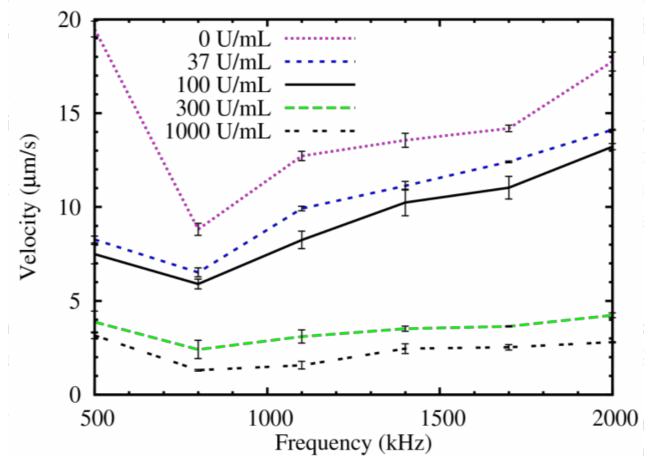
Figure 5. Negative DEP spectrum curves for cutoff levels of CA 19-9 for the detection of pancreatic cancer at 0 U/mL, 37 U/mL,100 U/mL, 300 U/mL, and 1000 U/mL. The error bars show the confidence interval in each individual measurement that were calculated using six measurements per